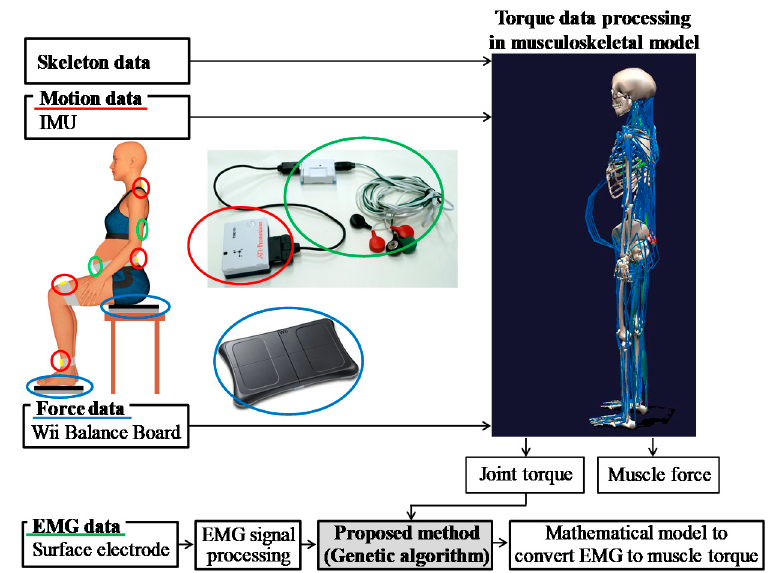
Figure 3. Overview of the system used to estimate muscle torque considering co-contraction activation using a genetic algorithm (GA). EMG: electromyography, IMU: inertial measurement unit.